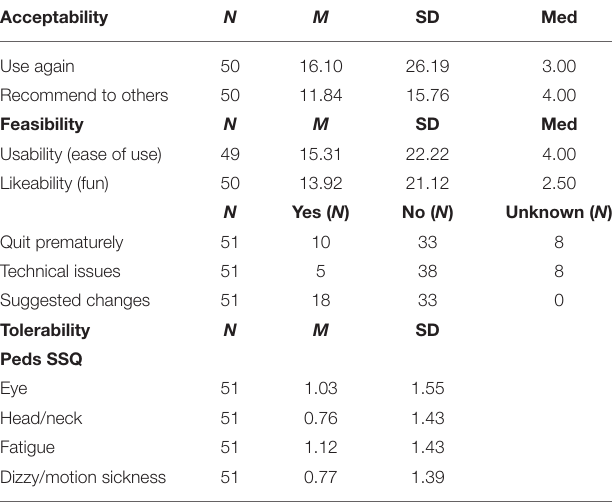
TABLE 2 | Descriptive statistics of pediatric participants.